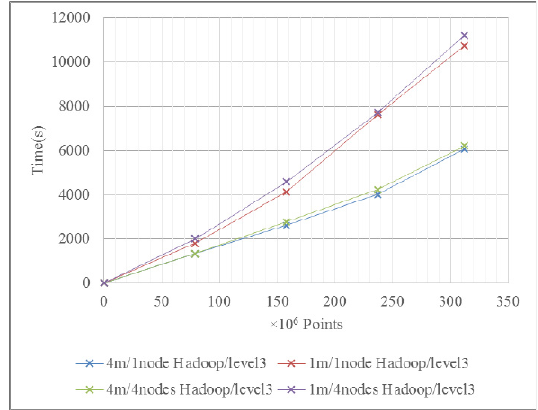
Figure 5(b).Different nodes of Hadoop